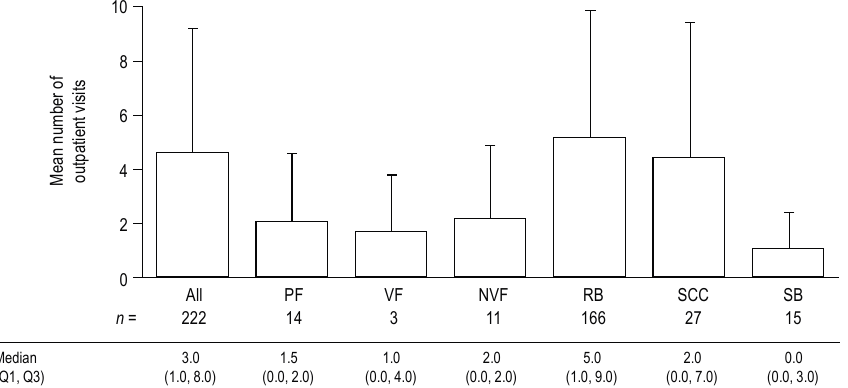
Figure 5. Mean number of outpatient visits for each type of SRE and for all types of SRE combined. Data shown as mean (+standard deviation) number of outpatient visits per SRE. Median (Q1, Q3) values are displayed below the graph. Data for PF are shown first overall, and then by VF and NVF